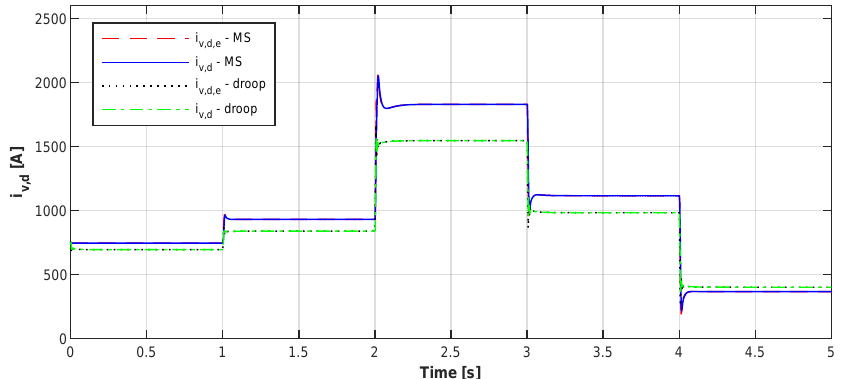
Figure 13. Output current component i v , d response of the master